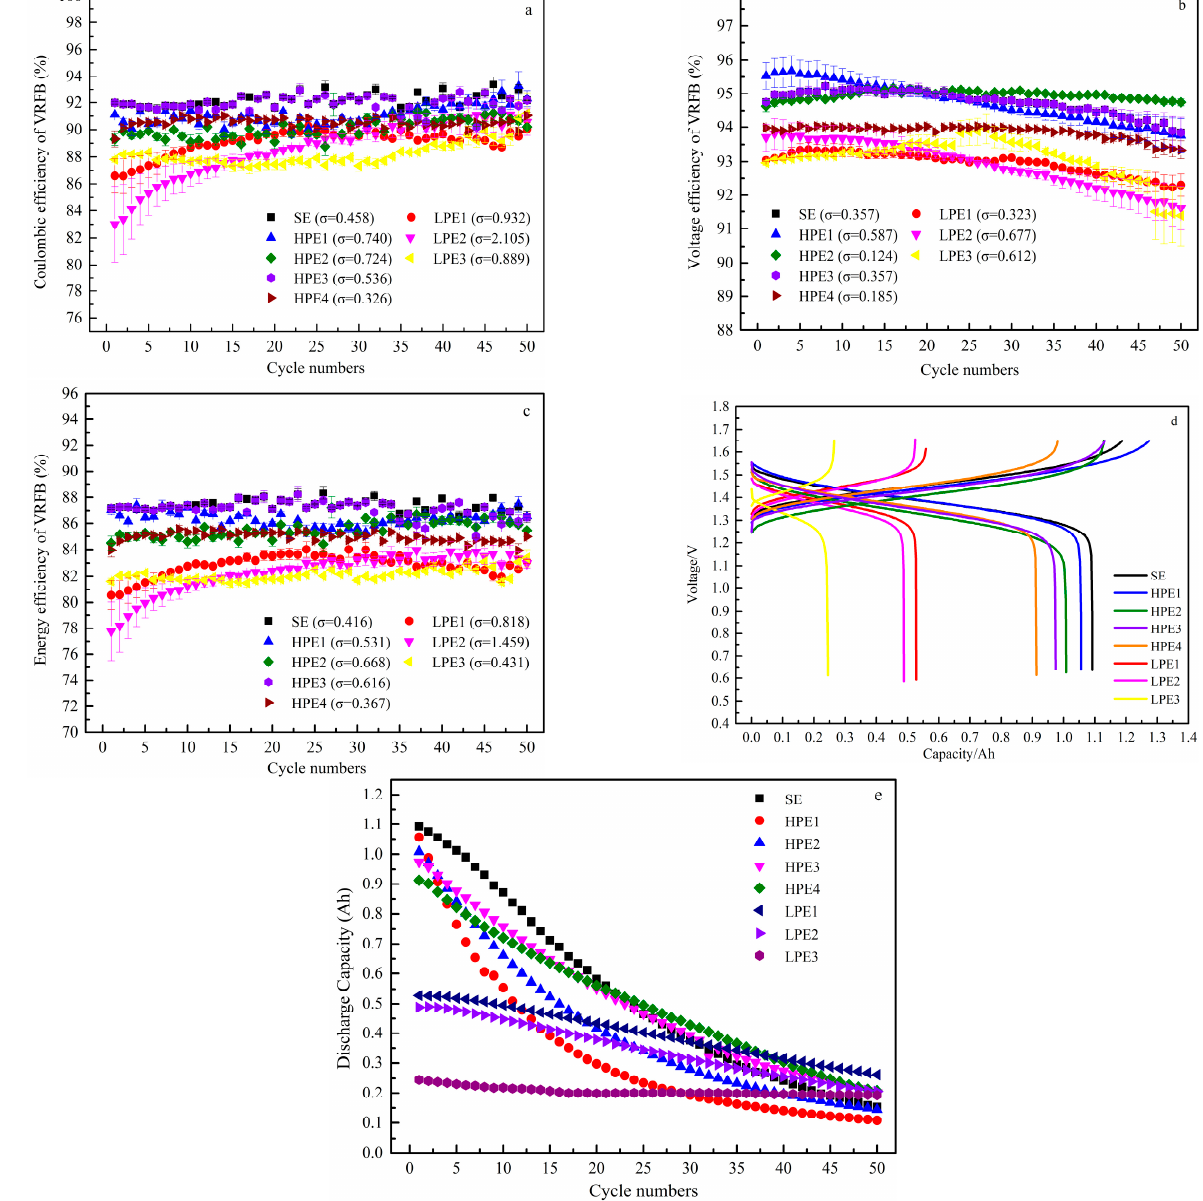
Figure 6. ( a ) Coulombic efficiency, ( b ) voltage efficiency, ( c ) energy efficiency, ( d ) charge–discharge curves, and ( e ) discharge capacity of VRFBs with different electrolyte purities at a current density of 40 mA cm − 2 ( σ represents the standard deviation).